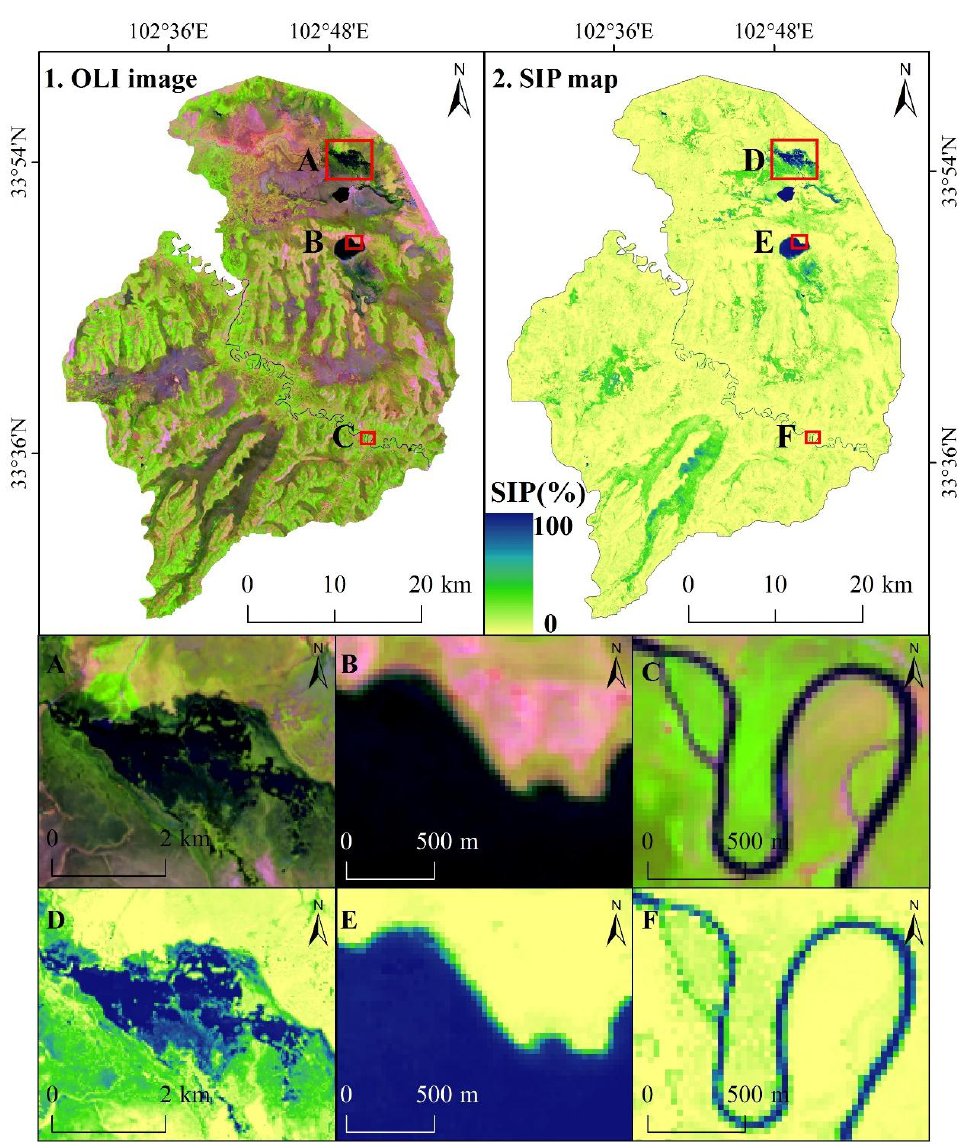
Figure 15. The SIP map of the Zoige Wetland National Nature Reserve that was derived based on the Landsat-8 OLI data using the prediction model with RT method in 2014. The OLI image (1) and three zoom-in windows ( A – C ) are shown with bands 6, 5, and 4 in red, green, and blue, respectively; and the corresponding SIP estimation of the SIP map (2) and three regions of interest ( D – F ).